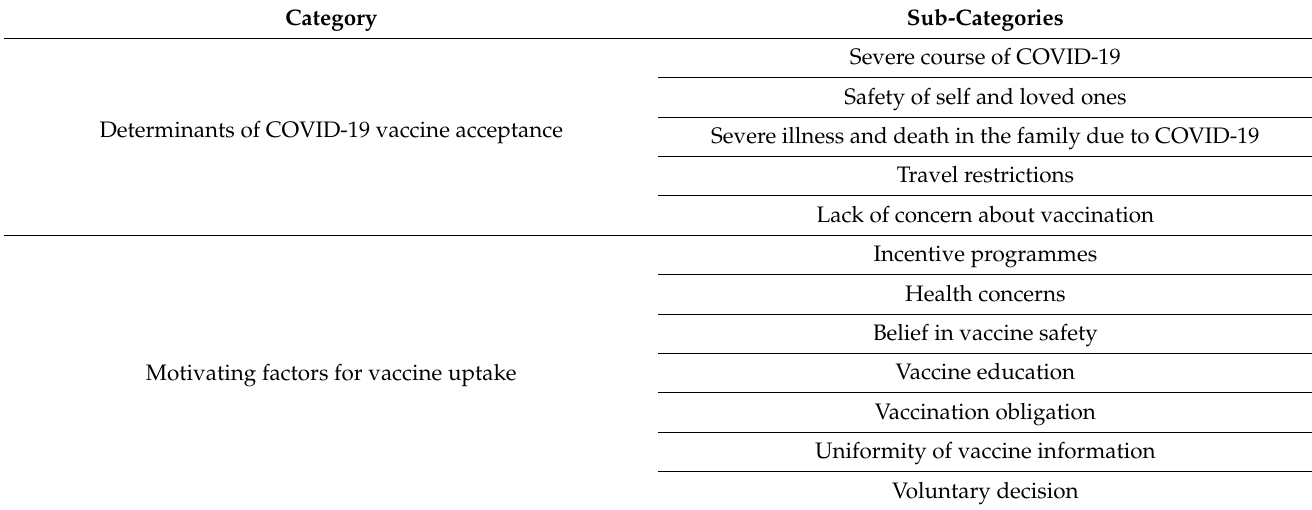
Table 3. Facilitators to COVID-19 vaccine